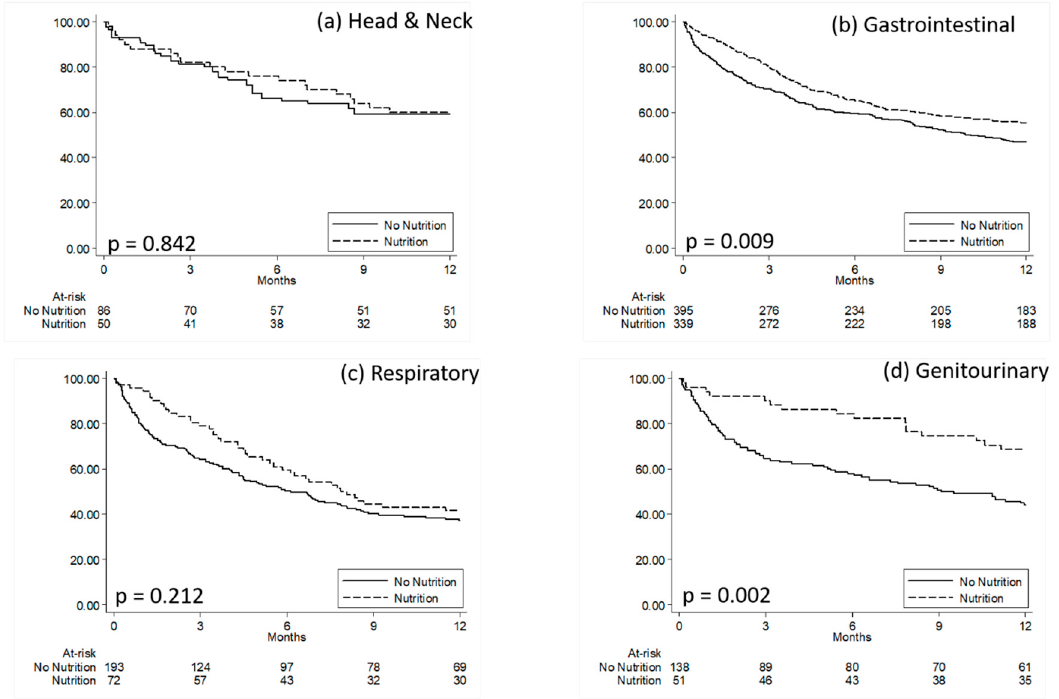
Figure 2. Kaplan–Meier curves comparing survival time since metastasis diagnosis for malnourished metastatic patients with clinical nutrition versus malnourished metastatic patients without clinical nutrition. ( a ) Head and Neck; ( b ) Gastrointestinal, ( c ) Respiratory, ( d ) Genitourinary. P: p -values from Log-Rank Tests.